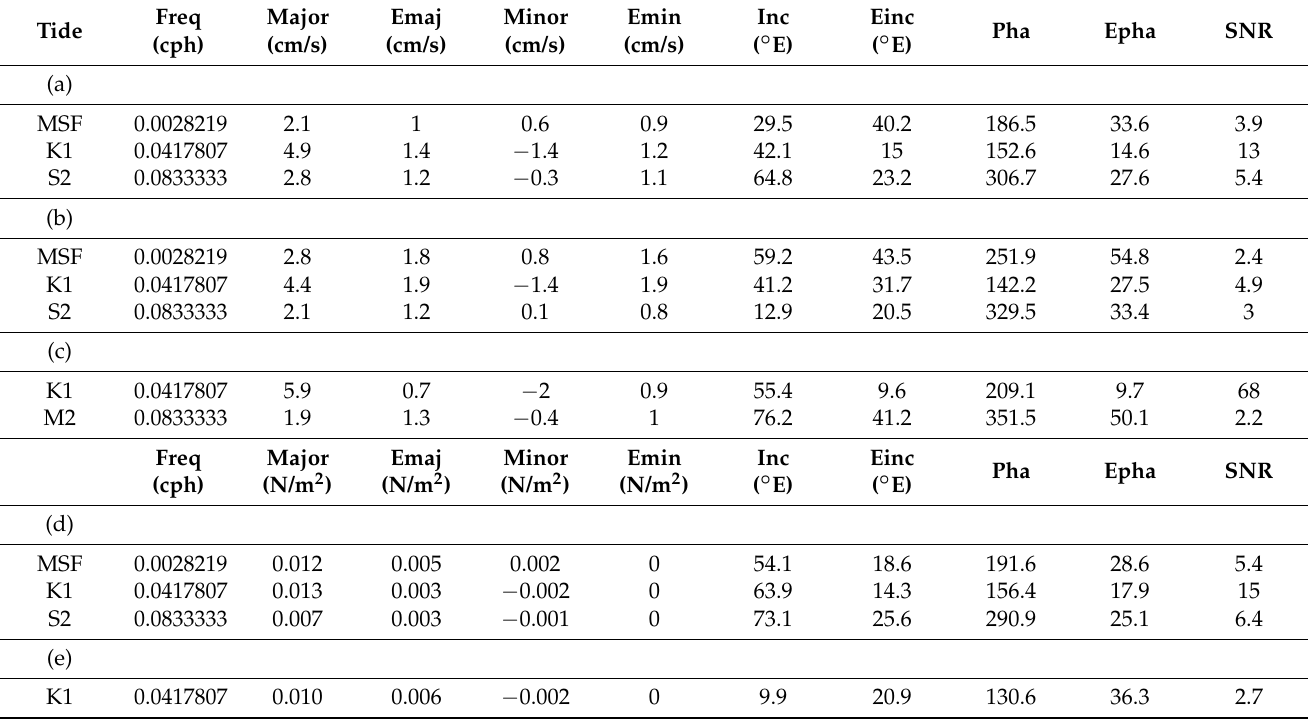
Table 6. Tidal ellipse parameters (major and minor axes, inclination and phase) together with 95% confidence levels (Emaj, Emin, Einc, Epha) for the tidal constituents with SNR greater than 2. (a), (b) and (c) refer to surface currents in April, May and June, respectively. (d) and (e) refer to wind stress for April and